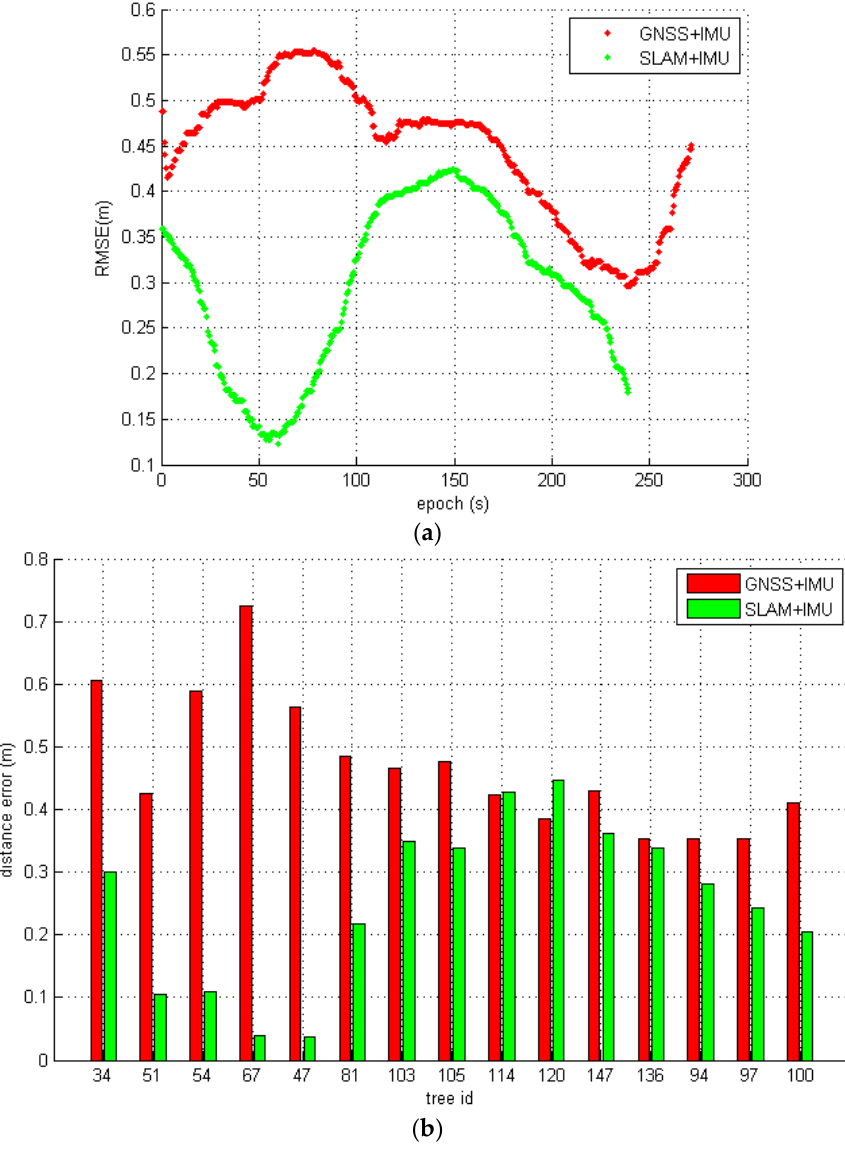
Figure 12. ( a ) Comparison of positioning errors between the SLAM + IMU and GNSS + IMU methods in a dense and mature forest; and ( b ) stem position error along the trajectory between the GNSS + IMU and SLAM + IMU methods in a mature forest environment. Table 4. The accuracy of the trajectory in a mature forest area with 142 trees (Unit: m).